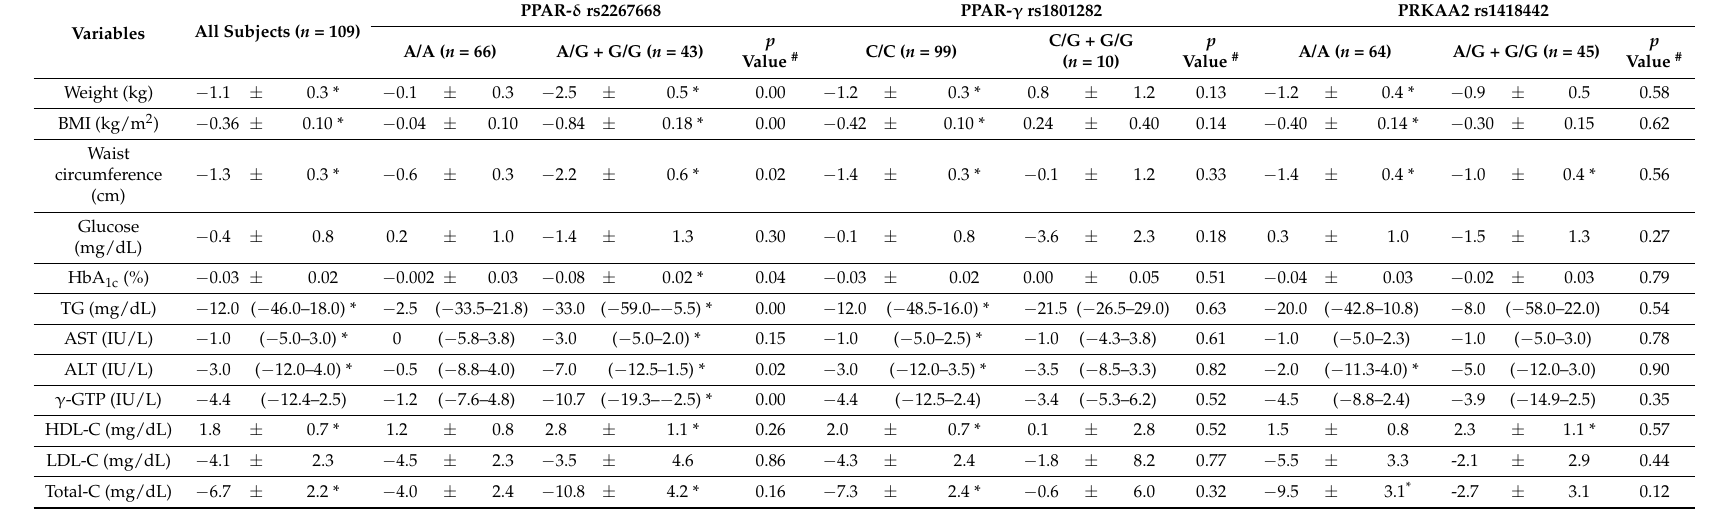
Table 2. Changes in the measured variables according to genotype groups of PPAR- δ , PPAR- γ , and PRKAA2